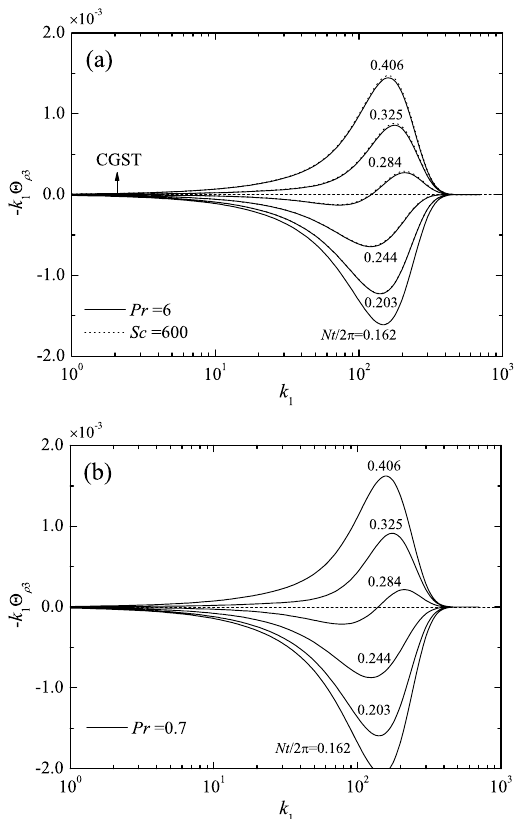
Fig. 3 Time variations of the cospectra of the vertical turbulent scalar flux in (a) thermally stratified water (Pr = 6) and salt-stratified liquid (Sc = 600) flows and (b) thermally stratified air (Pr = 0 . 7) flow. The cospectra are pre-multiplied by k 1 and the positive values of − k 1 Θ ρ 3 indicate CGST. The numbers indicate the dimensionless time, Nt / 2